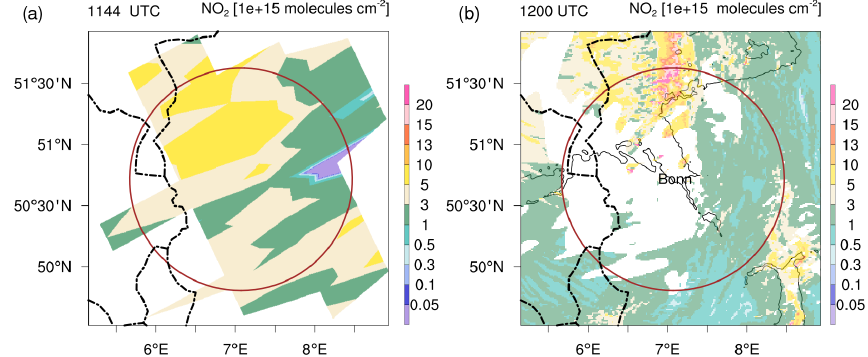
Figure 2. Satellite (a) and model (b) estimates of integrated vertical tropospheric column (VTC) for NO 2 over the Bonn radar domain on 4 July 2015.